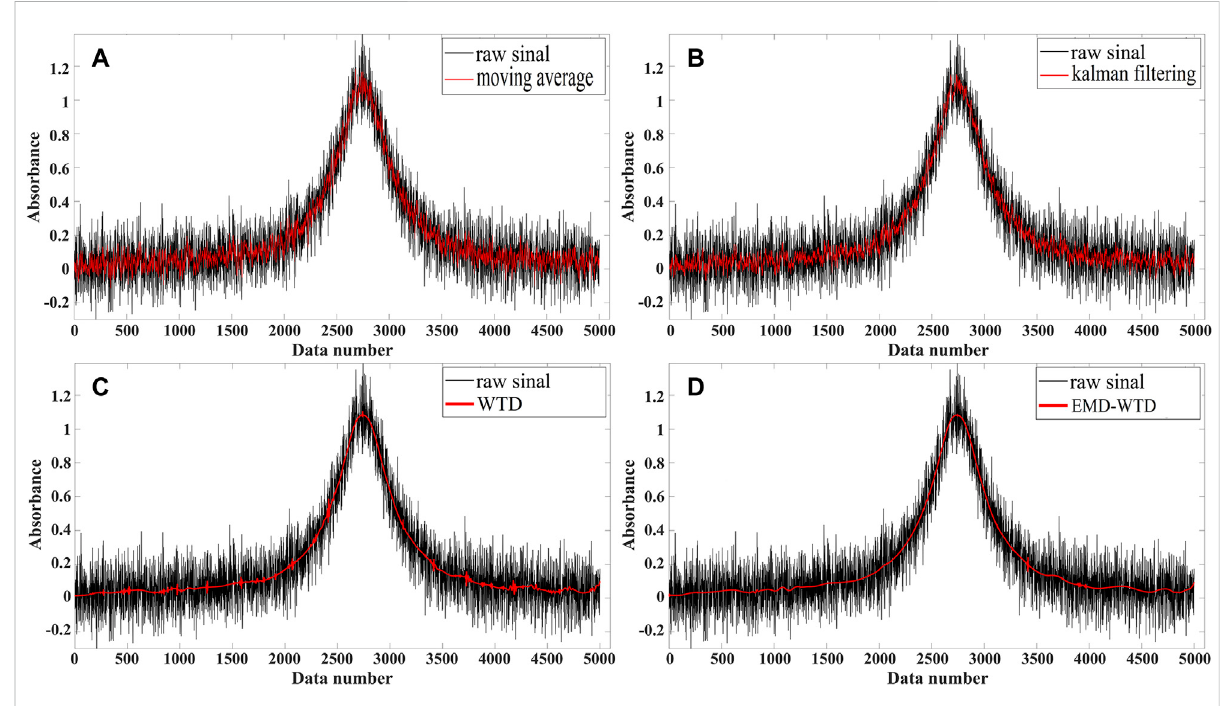
FIGURE 6 Comparison of moving average, Kalman fi ltering, WTD and EMD-WTD methods.